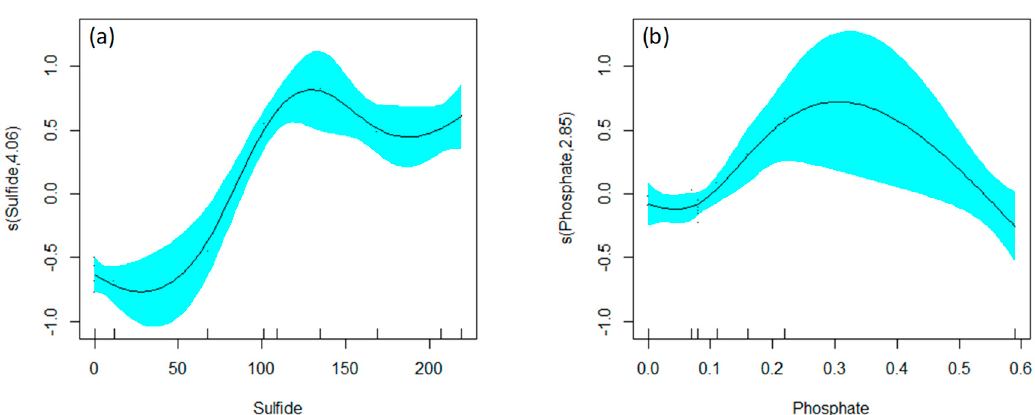
Figure A1. Functional forms of the smoothed (s) covariates ( a ) sulfide and ( b ) phosphate in µ M of the generalized additive model.